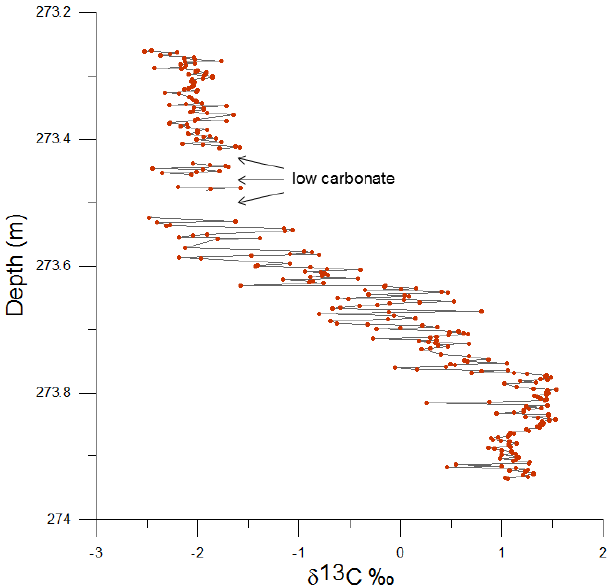
Figure 1. Onset of the carbon isotope excursion at Millville, New Jersey (data replotted from Wright and Schaller,